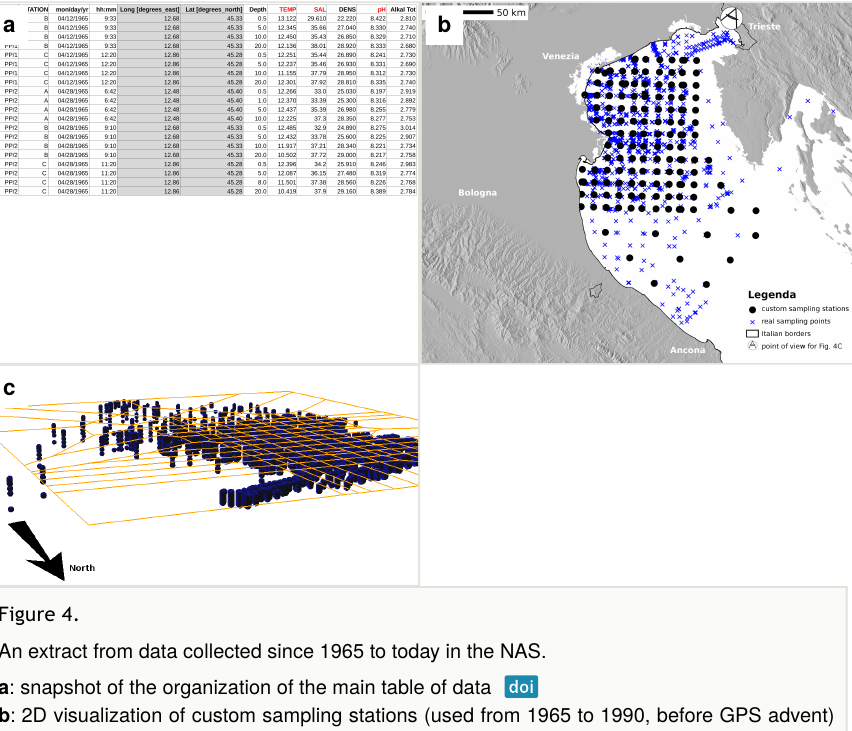
An extract from data collected since 1965 to today in the